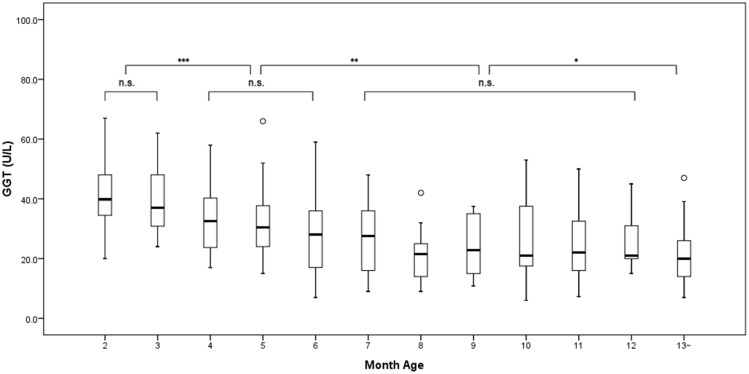
The variation of GGT levels in patients with ATP8B1 or ABCB11 deficiency.*P<0.05; **P<0.01; ***P<0.001; n.s., not significant.